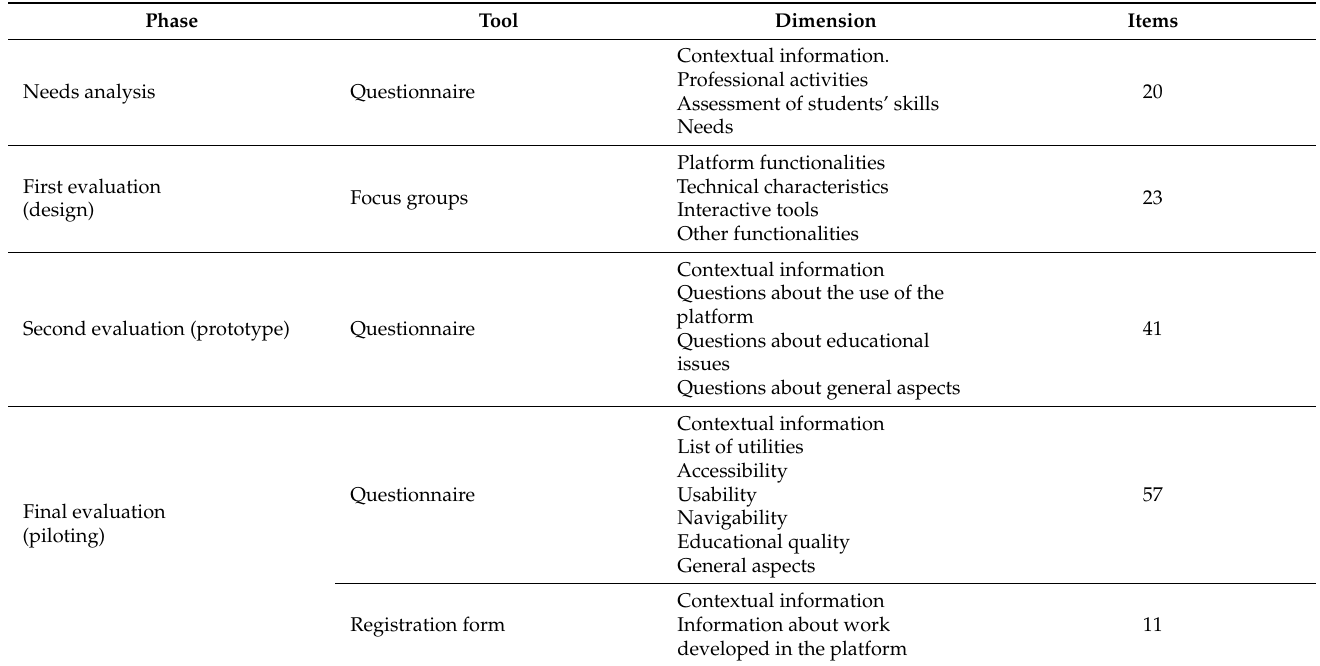
Table 1. Research phases and description of evaluation